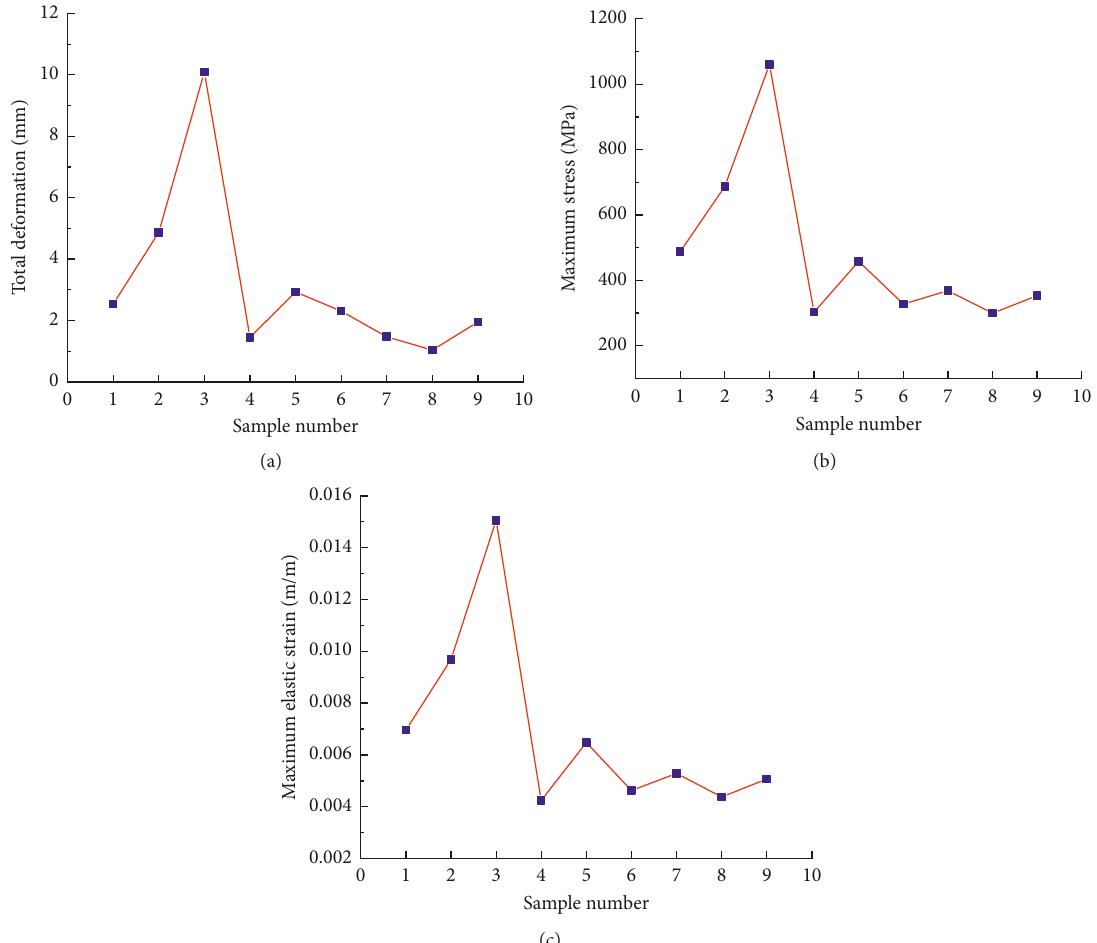
Figure 15: Simulated three-point bending test results. (a) Deformation in each sample and maximum (b) stress and (c) strain in each